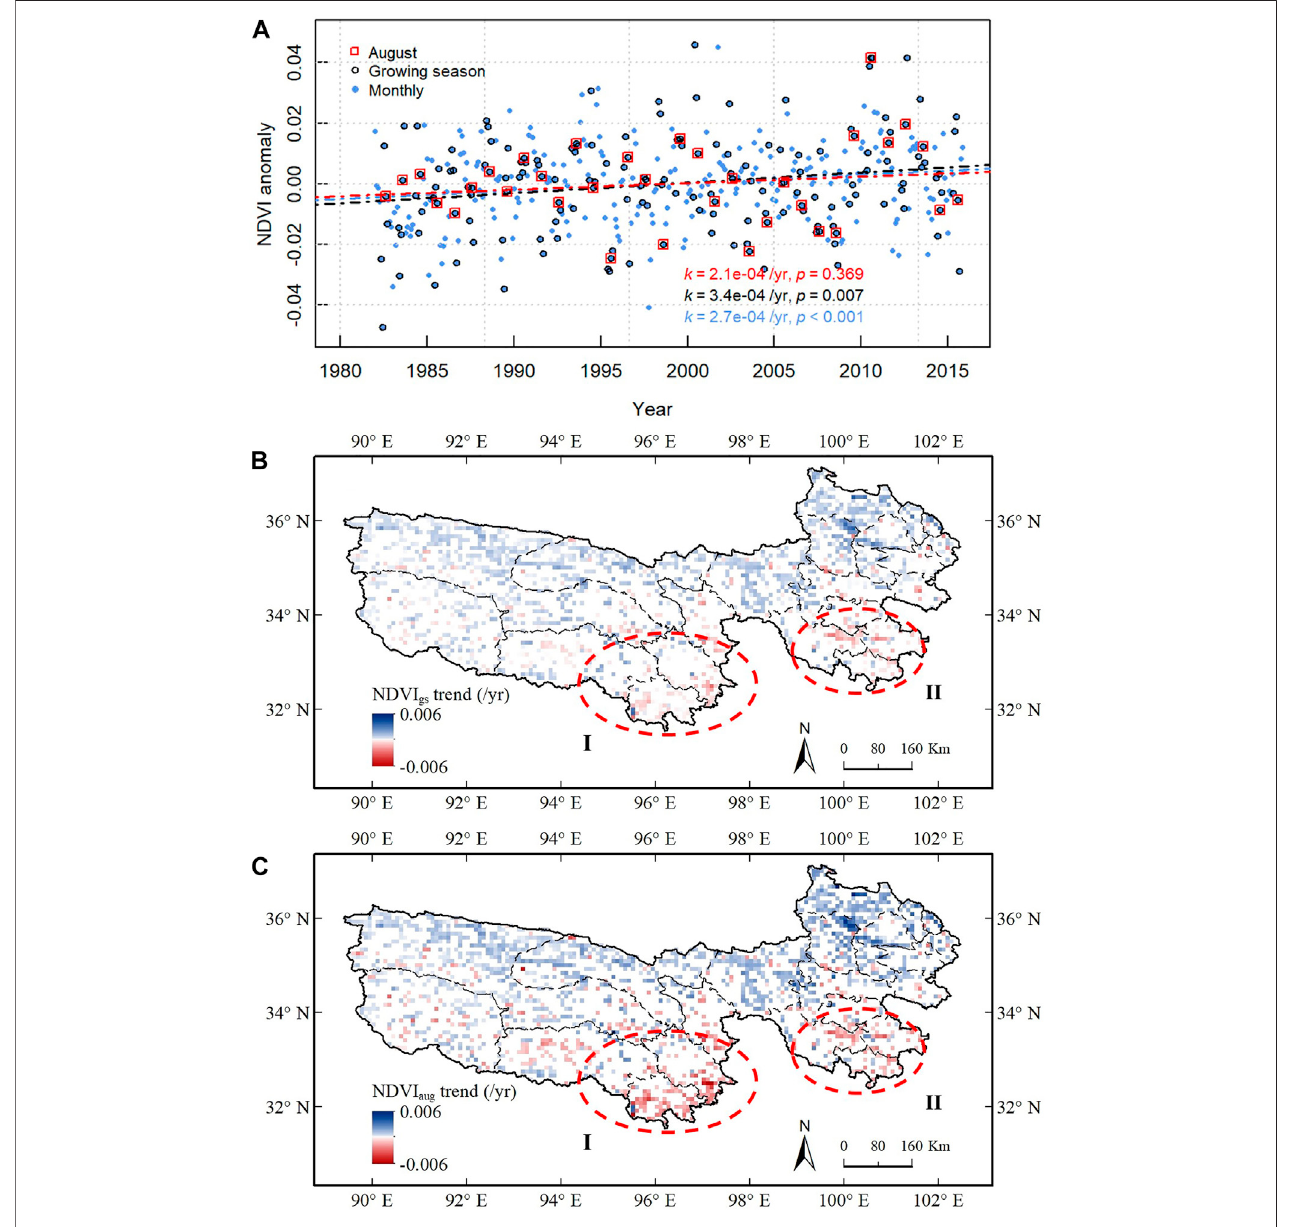
FIGURE4| Assessmentofgrazingpressureonvegetation. (A) Inter-annualtrendsofNDVI aug NDVI gs ,andNDVI mon fortheTRHRduringtheperiod1982 – 2015; (B) Spatial distribution of inter-annual trend for NDVI gs during the period 1982 – 2015; (C) Spatial distribution of inter-annual trend for NDVI aug during the period 1982 – 2015.